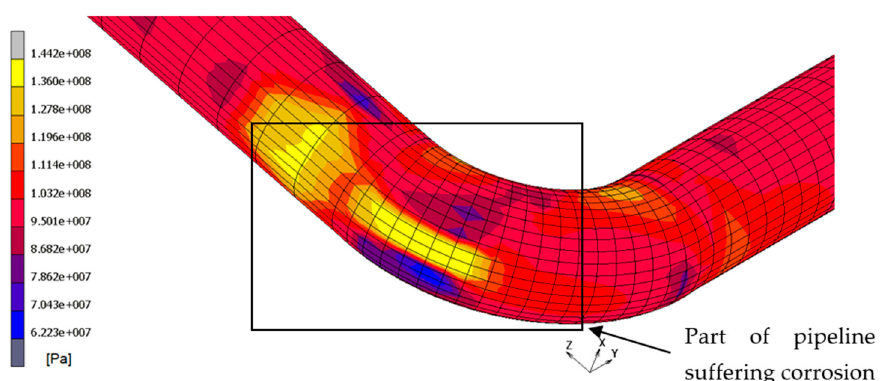
Figure 6. Equivalent von Mises stress, bottom layer—case 5.